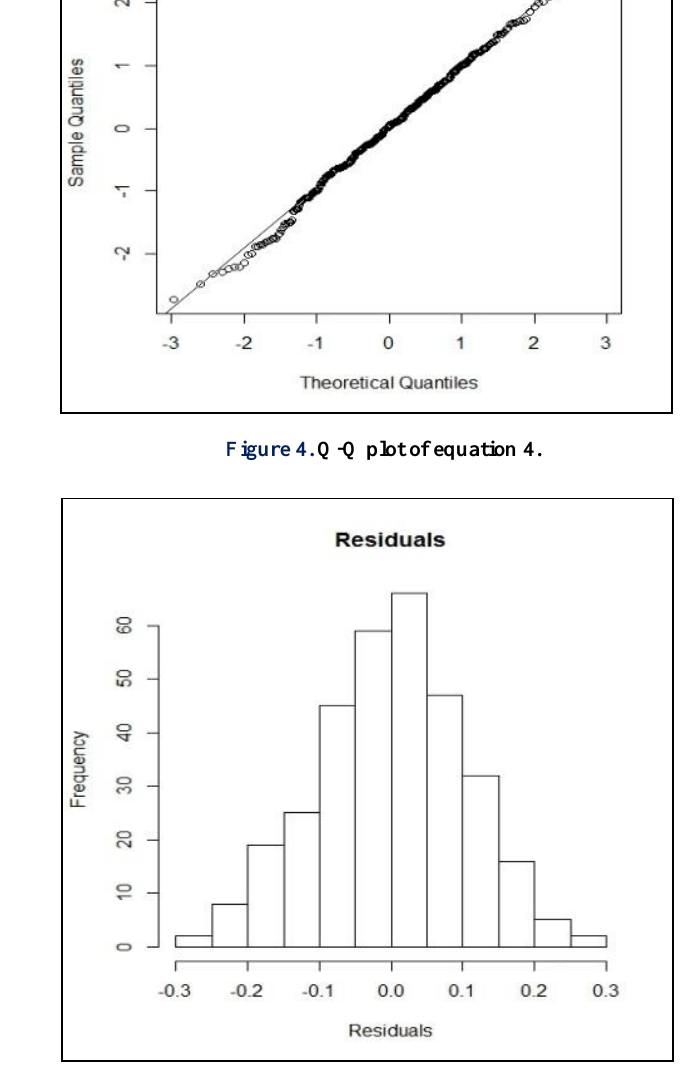
Figure 5. Residuals frequency of equation